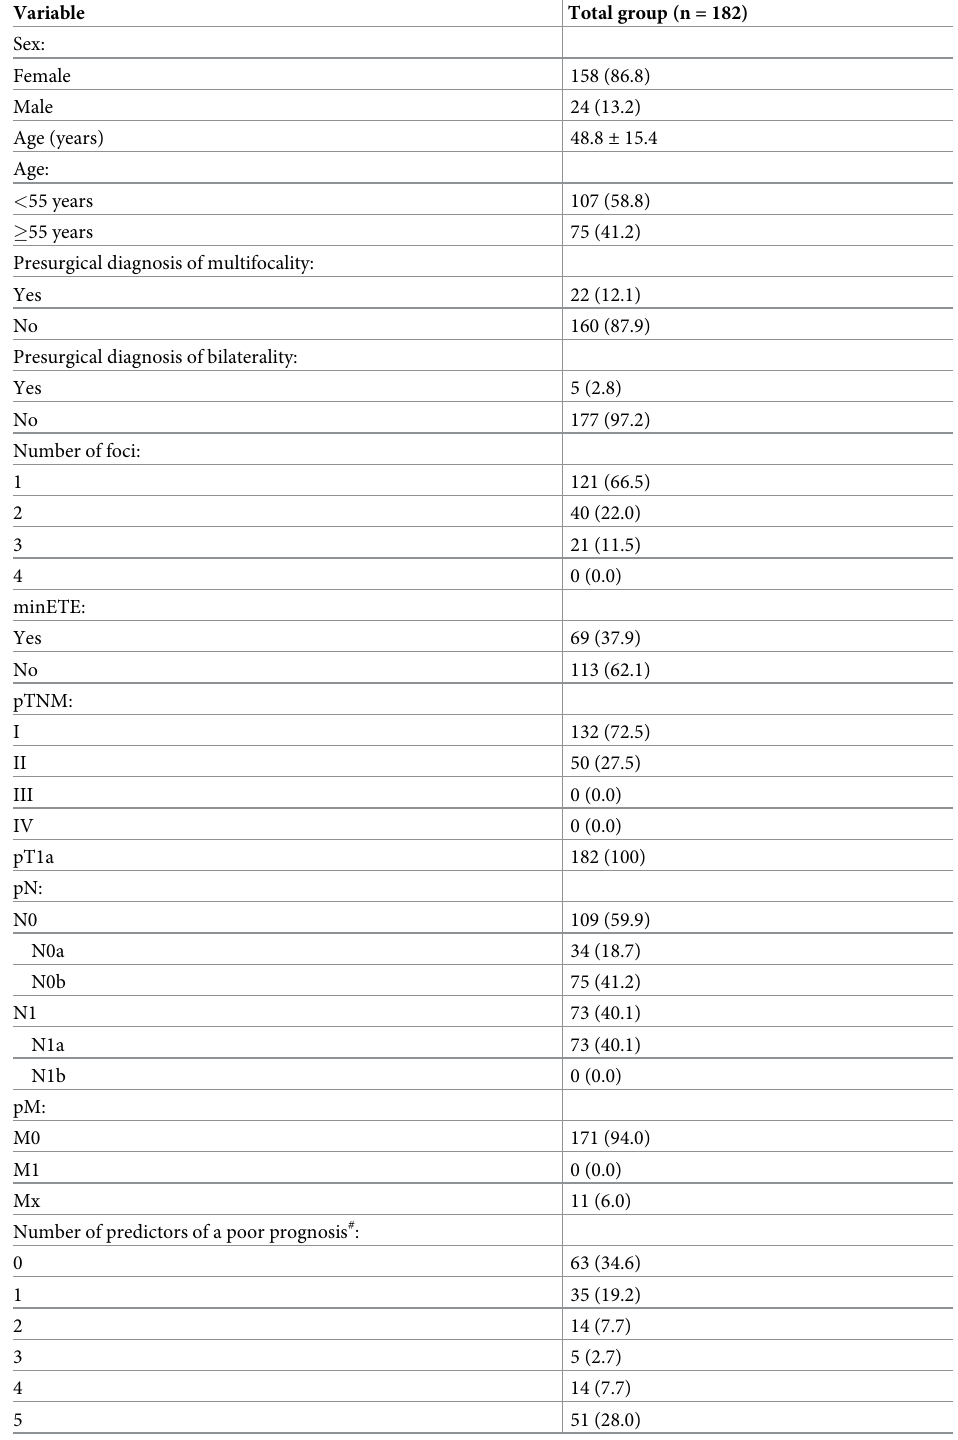
Table 1. Demographic, clinical and histopathological characteristics of PTMC